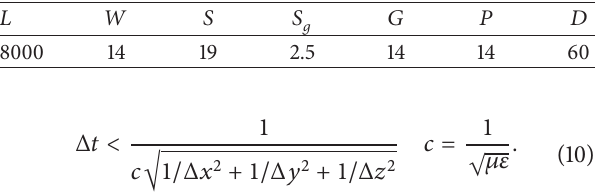
Table 1: Parameters of the microstripline structures (in